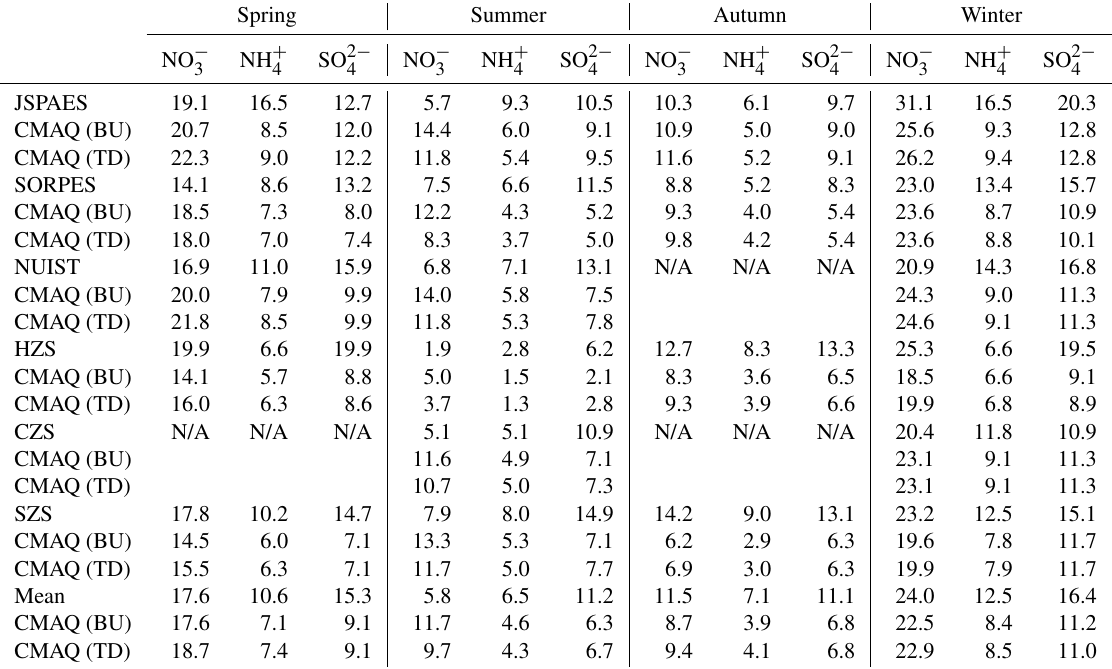
Table 2. Comparison of observed and simulated NO − information on SNA observation sites is provided in Table S2 in the Supplement. BU and TD indicate the CMAQ modeling with the bottom- up and top-down estimate of NO x emissions,